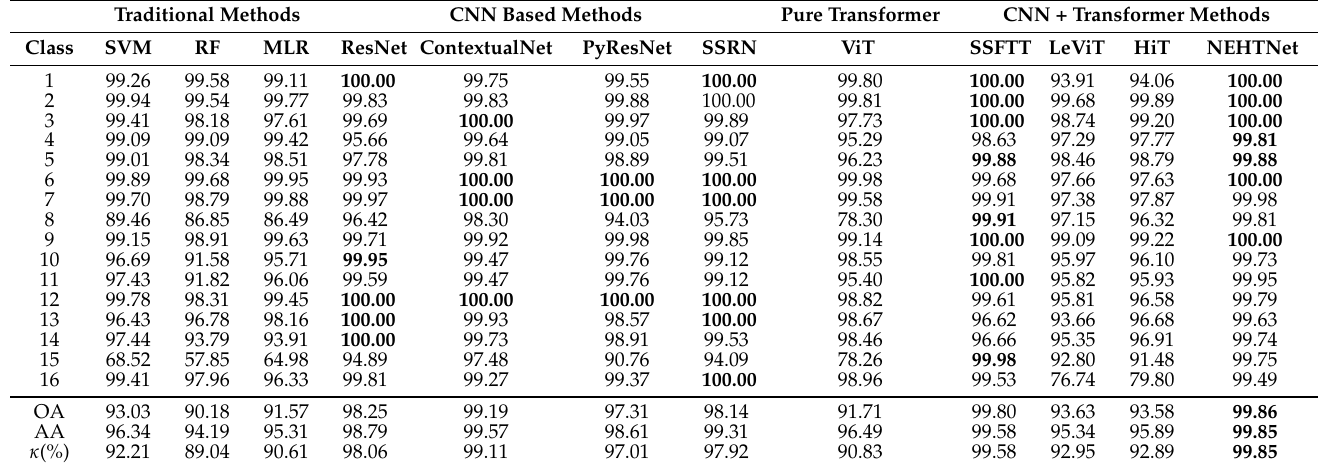
Table 7. Classification Accuracy of Different Methods for Labeled Pixels of The SA Data Set.